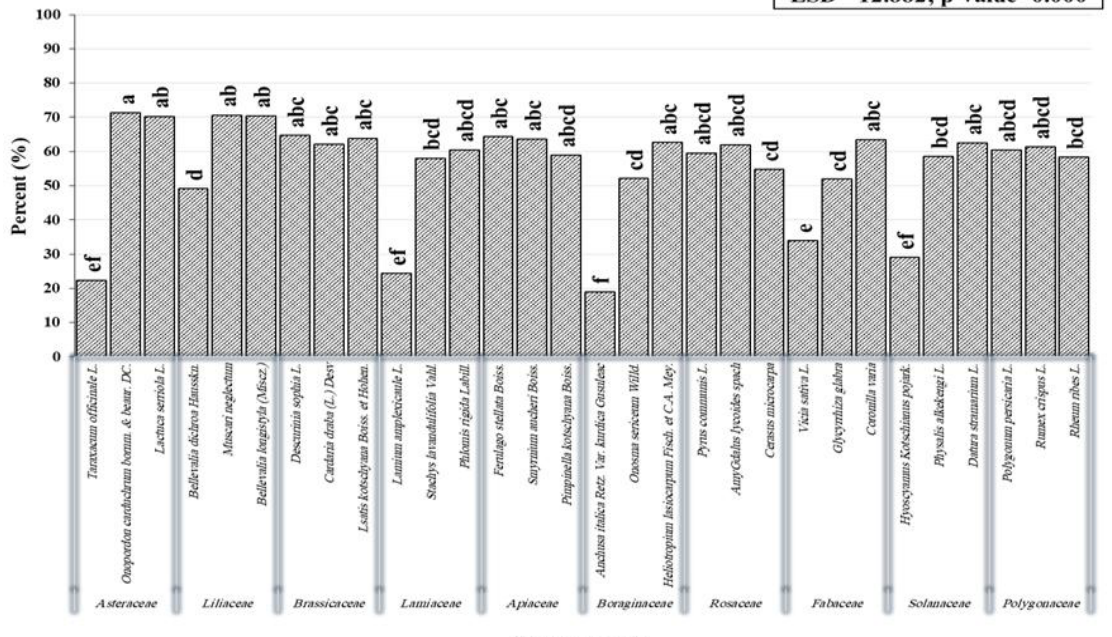
Fig. 8. Mean value of antioxidant capacity of studied plant species by ABTS